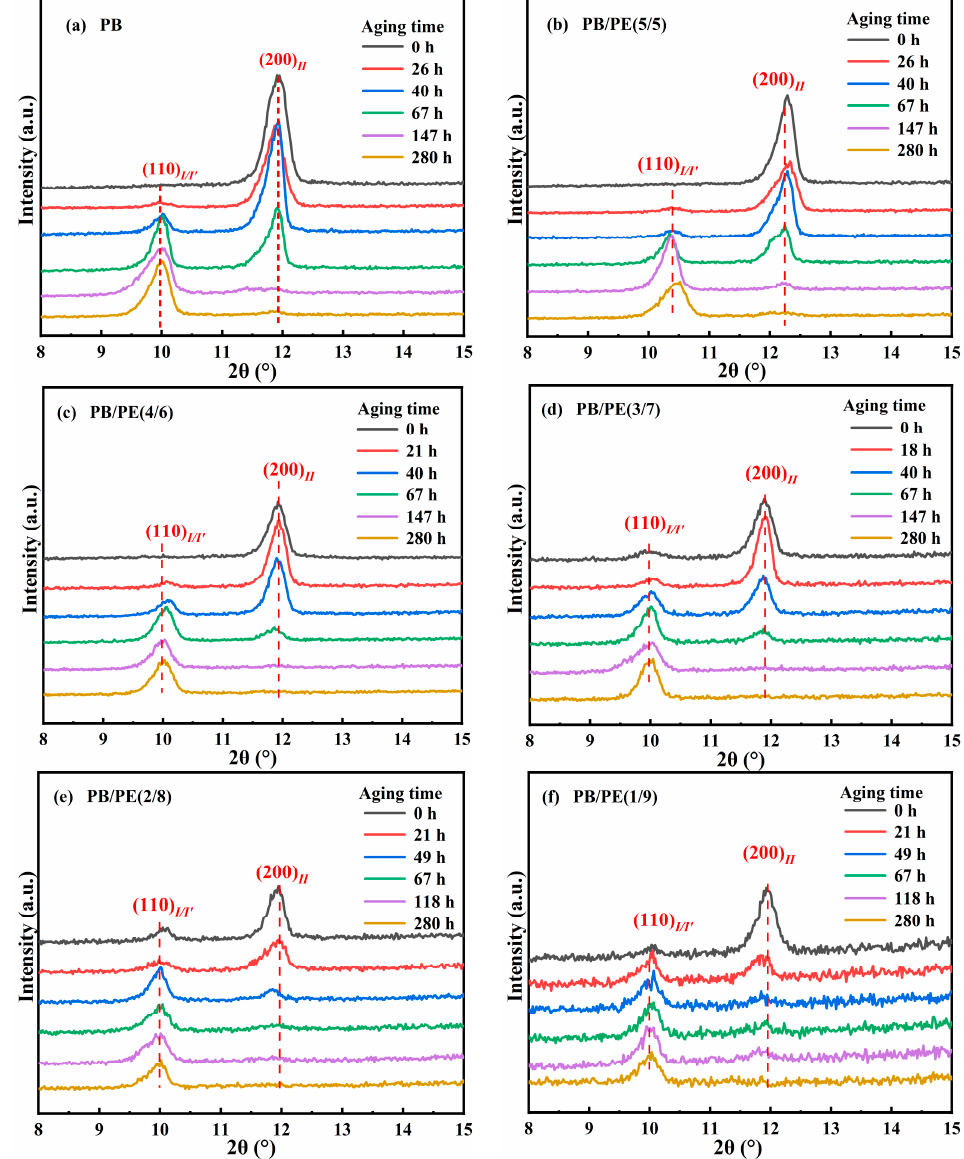
Figure 8. The XRD results of ( a ) PB, ( b ) PB/PE(5/5), ( c ) PB/PE(4/6), ( d ) PB/PE(3/7), ( e ) PB/PE(2/8), and ( f ) PB/PE(1/9) after aging at 25 °C for different durations.